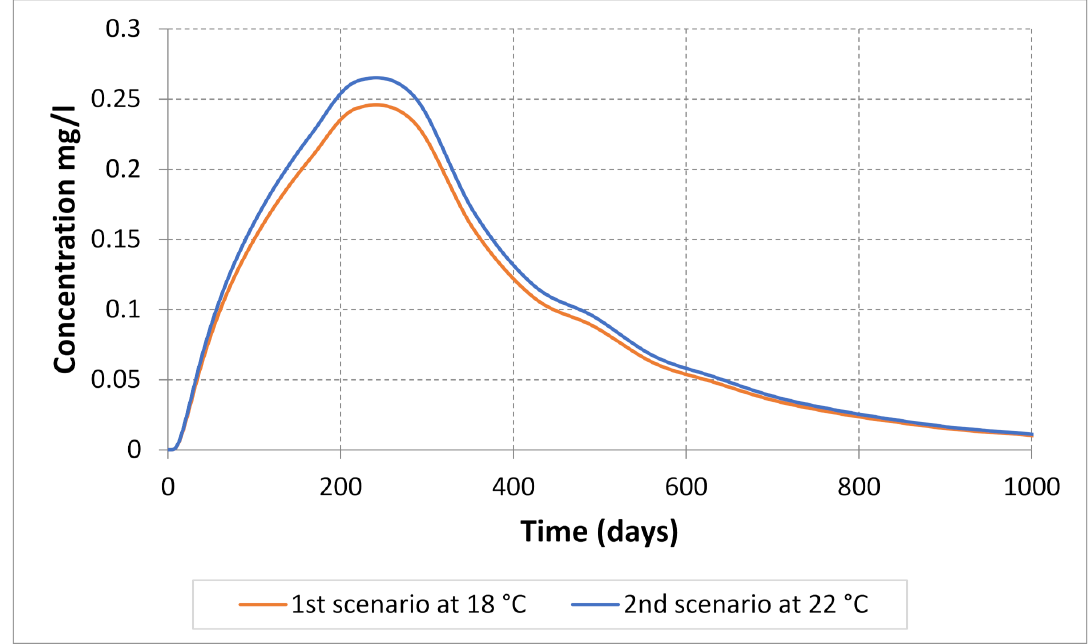
Figure 3. C max of benzene at depth 100 cm—Sandy clay loam